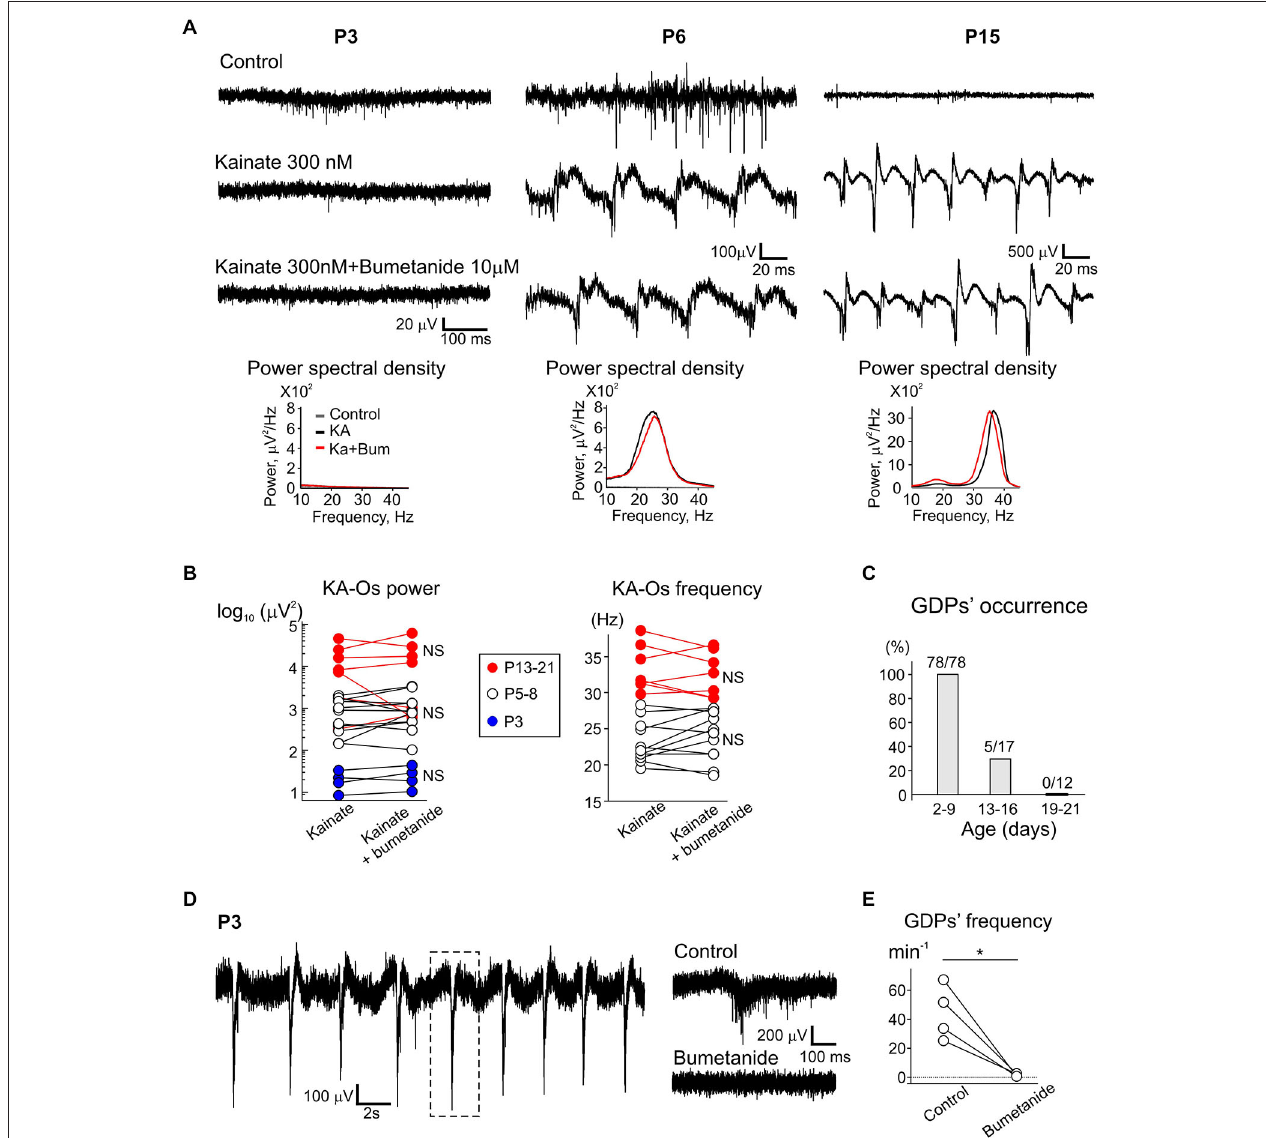
was pre-applied 10 min prior to combined application with kainate and the responses were compared with the responses evoked by kainate only; in older animals, bumetanide was applied in the presence of kainate. (C) Occurrence of GDPs in slices for three age groups. (D) Effect of bumetanide on GDPs. An example trace of the activity in CA3 pyramidal cell layer in control conditions. Dot rectangle presents border of extended trace shown in left. Right, bottom: example trace of CA3 pyramidal activity in the presence of bumetanide. (E) Summary plot of the effect of bumetanide on GDPs (pooled data from 4 slices,